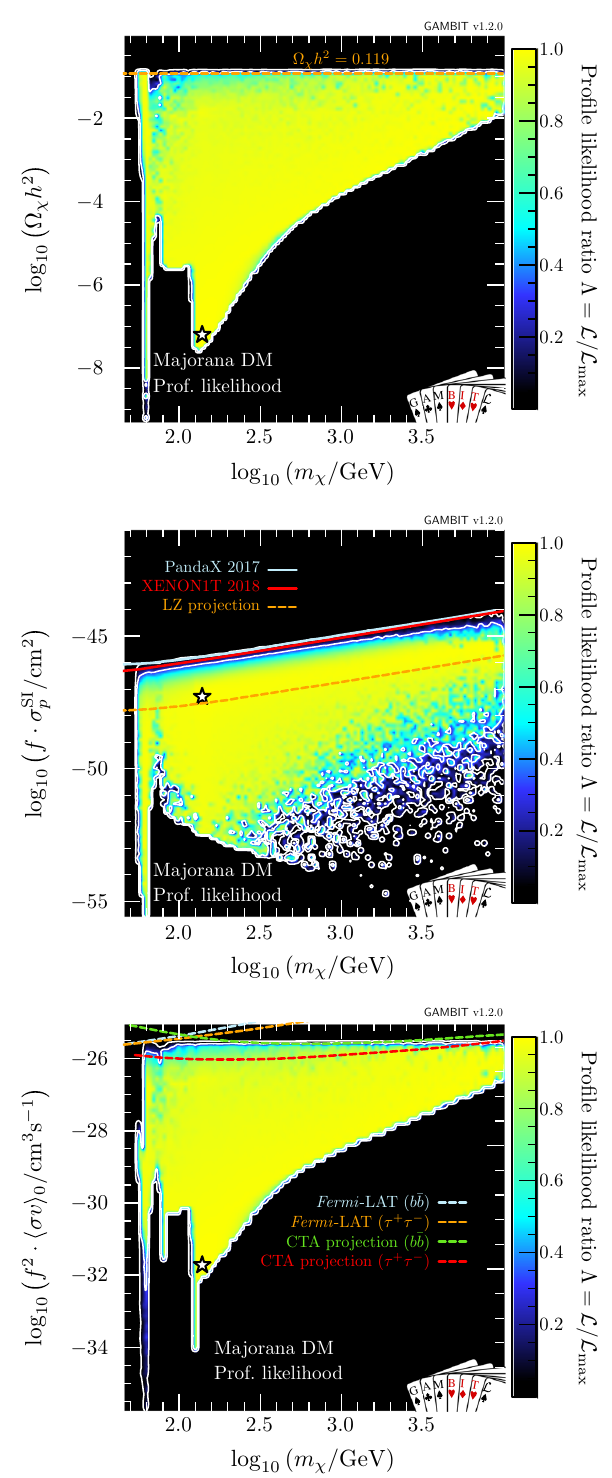
Fig. 5 Same as Fig. 2 but for Majorana fermion DM. Again, f ≡ (cid:14) χ /(cid:14) 2 -suppression in the spin- DM . For illustration, as there is a q independent cross-section (see Eq. 25), we show σ SI computed at a reference momentum exchange of q =